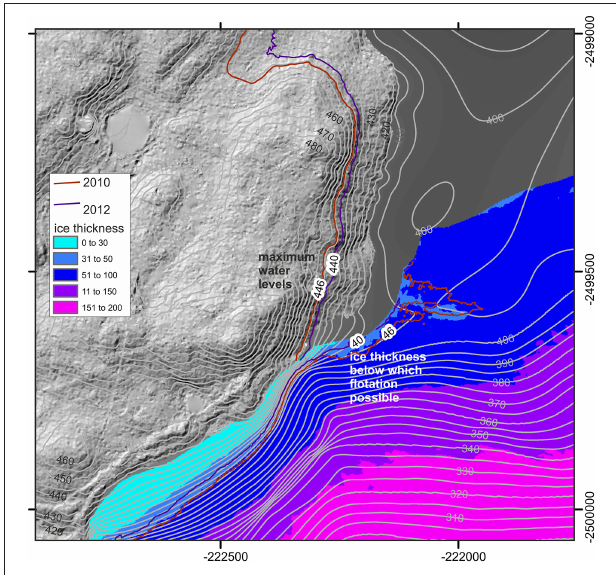
FIGURE 9 | Detail of the vicinity of the subglacial conduit, with interpolated contours at 5m intervals, and ice thickness calculated as the difference between the bed and the ice surface in a DEM derived from August 2011 stereo images. Maximum water levels are marked in years 2010 and 2012 and the corresponding ice thickness below which flotation would be possible is delimited. Map grid coordinates are UTM 22N.